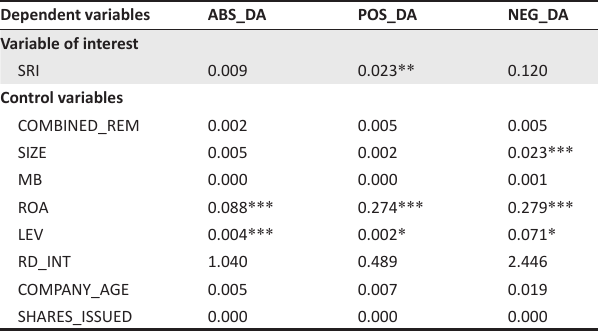
TABLE 5: Real earnings management on corporate social responsibility